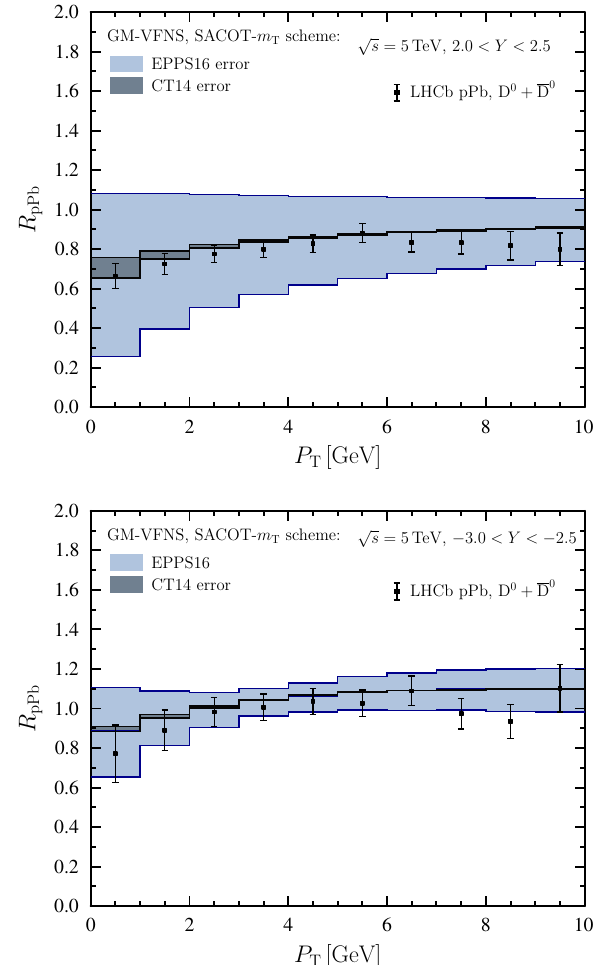
Fig. 3 The EPPS16 and CT14NLO uncertainties for D-meson produc- tion in forward (upper panel) and backward (lower panel) direction in p-Pb collisions. The data are from the LHCb collaboration